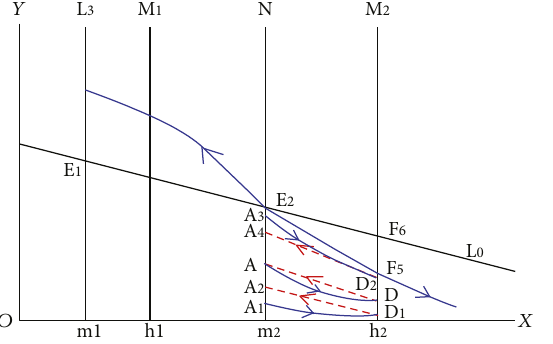
Figure 13: Structure diagram in R + h 2 < m 2